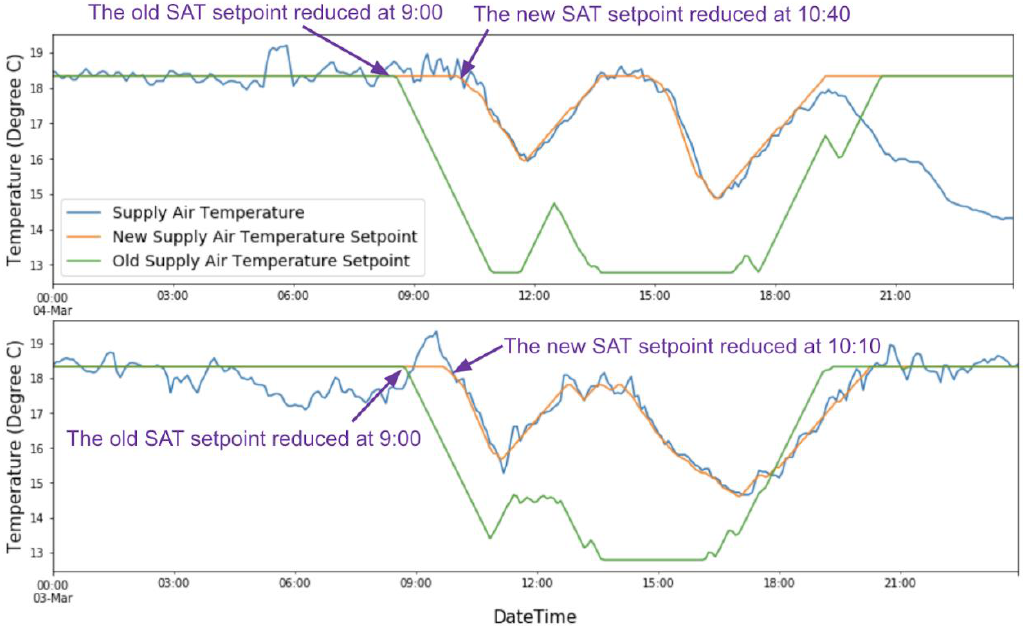
Figure 7. The SAT setpoint of AHU01 after the execution of the auto-correction algorithm (4 March 2020).